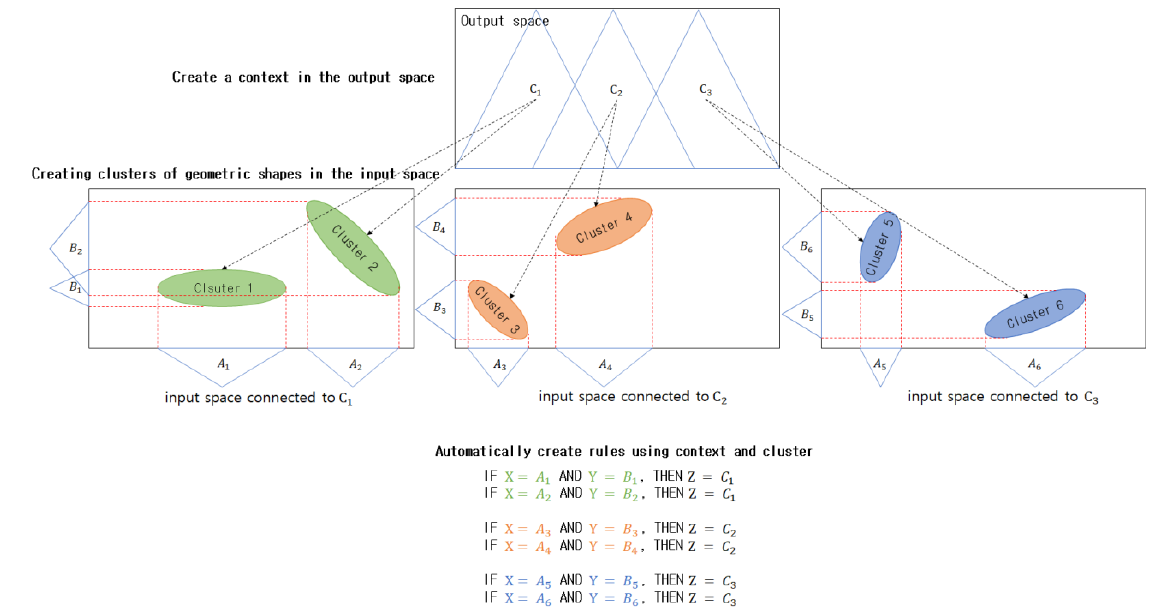
Figure 9. CGK clustering concept.